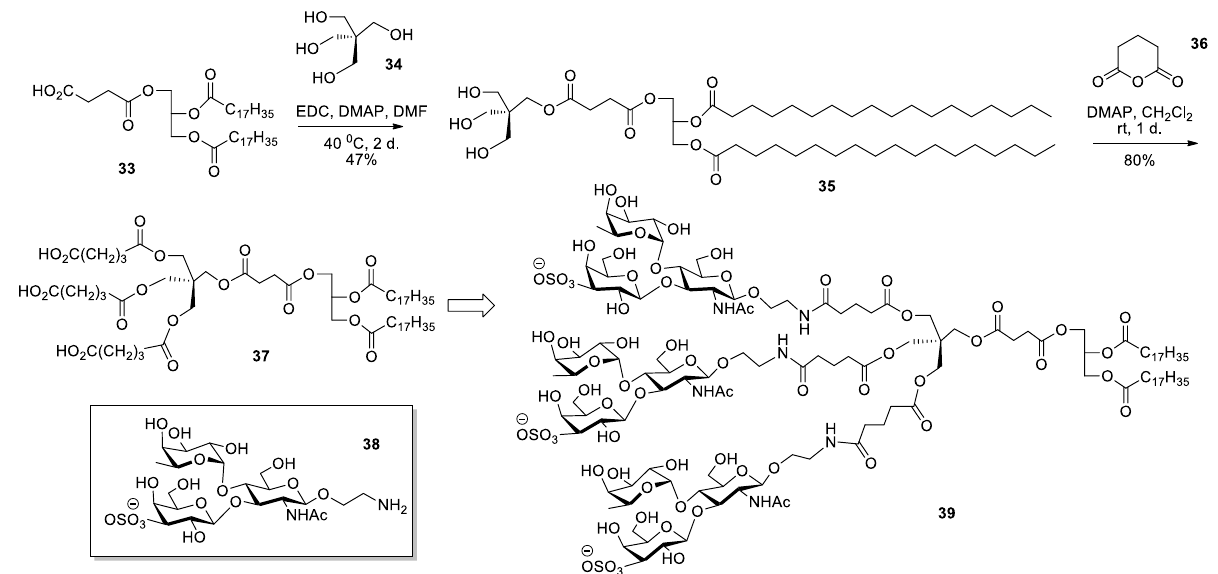
Scheme 6. Synthesis of an arborescent neoglycolipid harboring the important E-/P- selectin ligand as a 3 ′ - O --sulfated Lewis a trisaccharide in a trimeric dendron [36].